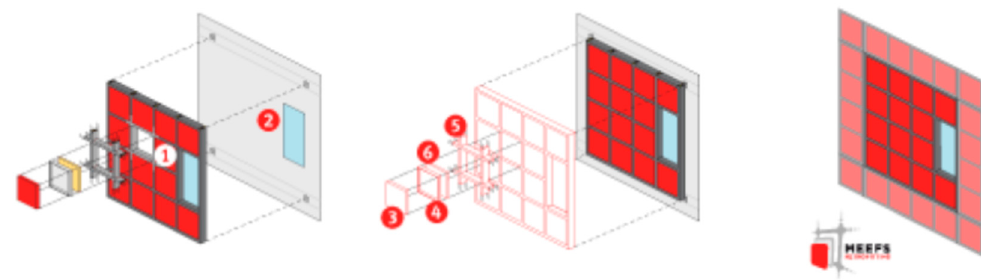
Figure 1. Meefs Façade System Constructive Process. 1) Multifunctional panel, 2) Existing façade